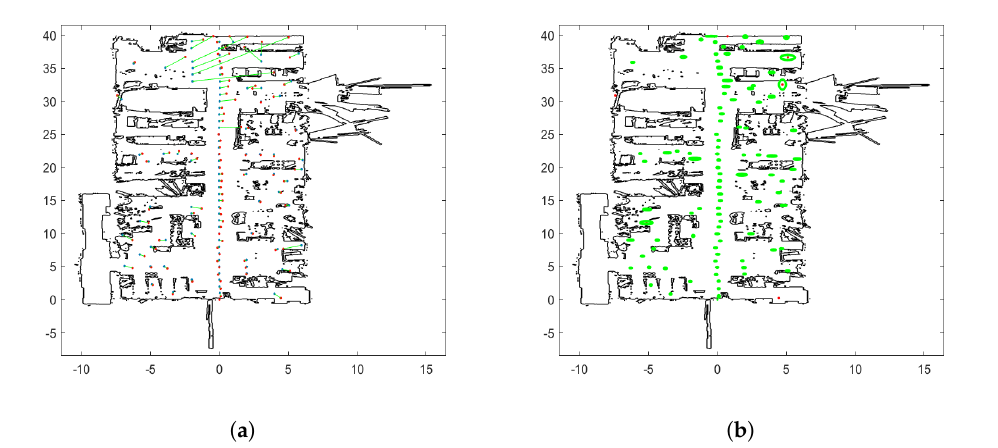
Figure A3. Static case results for Pozyx at 0.3m altitude. ( a ) Estimated positions from Pozyx (red) vs. ground-truth (blue) with connecting line (green). ( b ) Estimated positions from Pozyx (red) and standard deviation ellipsoids (green).